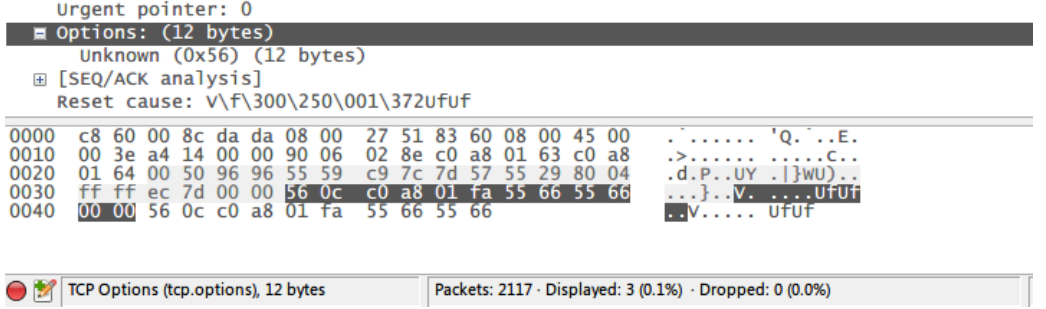
Figure 10. Packet dump viewed by Wireshark.